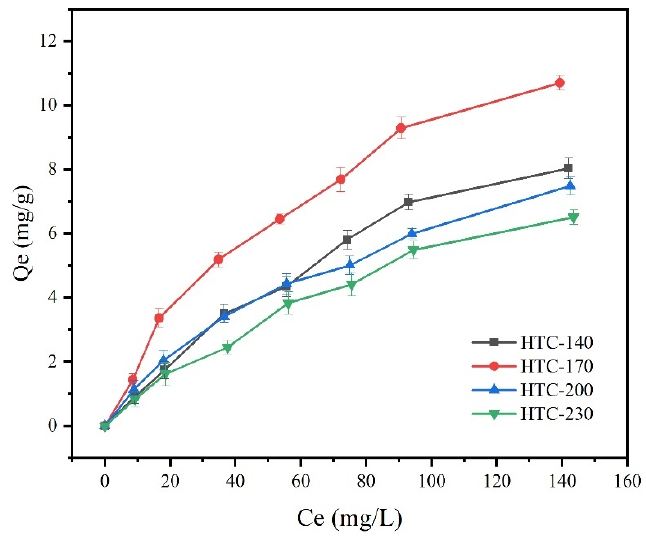
Figure 8. Effect of initial solution concentration on Cd 2+ adsorption by